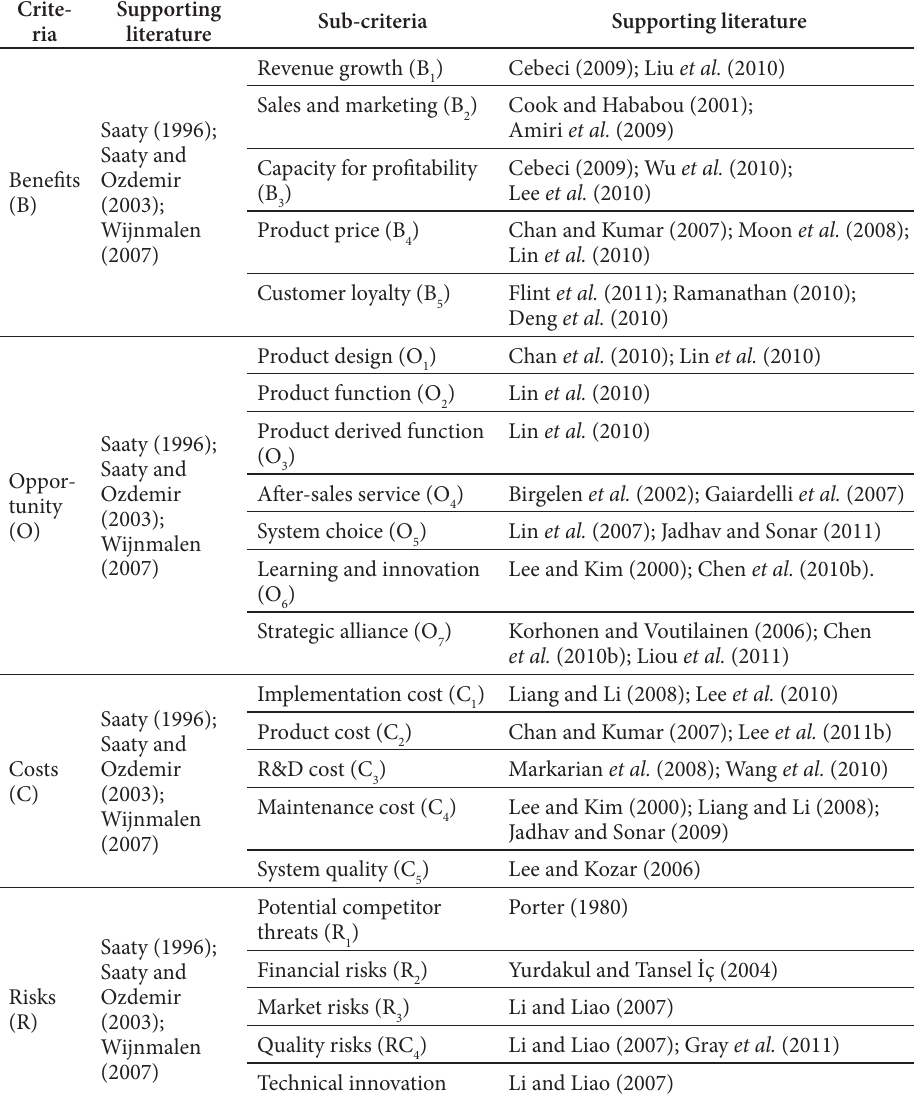
Table A1. Supporting literature of the BOCR performance evaluation criteria and sub-criteria Crite-